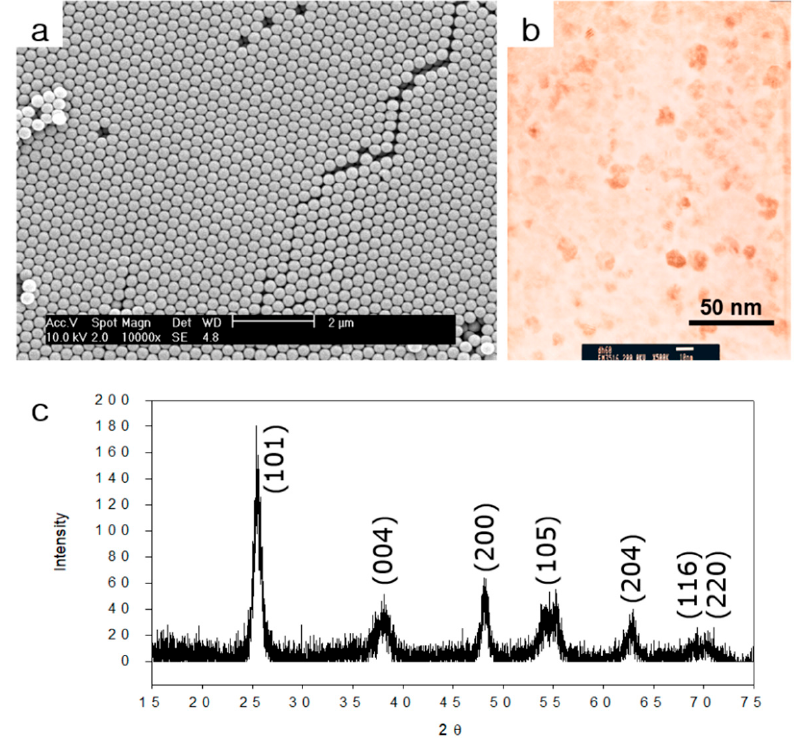
Figure 1. ( a ) SEM image of PS/HEMA latex nanoparticles. ( b ) TEM image and ( c ) x-ray diffraction data of titania colloidal nanoparticles.